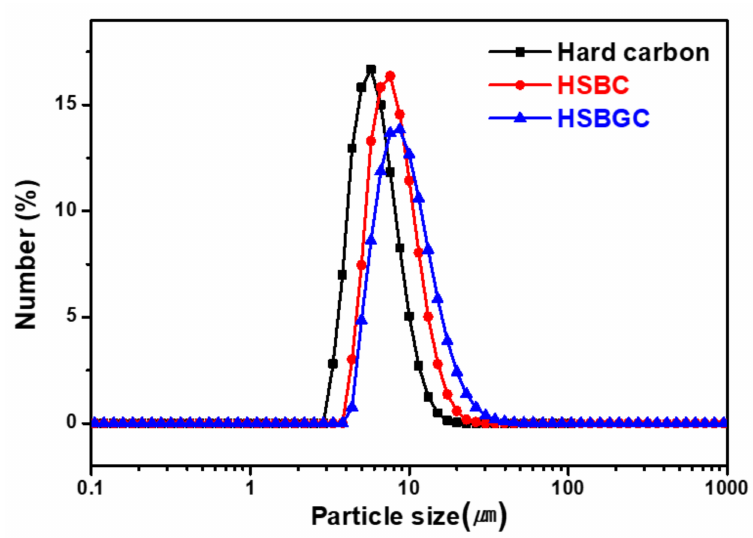
Figure 3. Particle size distribution of hard carbon and core/shell composite HSBC and HSBGC.